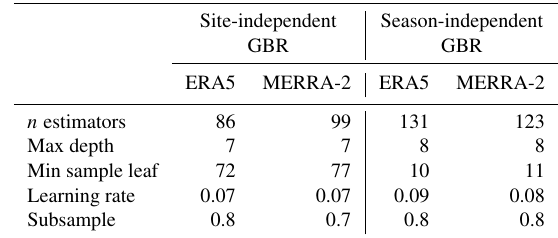
Table 1. Average hyperparameters of the optimized GBR models of all the studied glaciers: “ n estimators” is the number of addi- tive trees (i.e. iterations) in the GBR, “max depth” is the maximum depth that each tree can reach, “min sample leaf” is the minimum number of samples required to be at a leaf node of a tree, “learning rate” determines how quickly the GBR learns (it shrinks the contri- bution of the individual trees on the GBR prediction) and “subsam- ple” indicates the fraction of samples used for fitting the individual